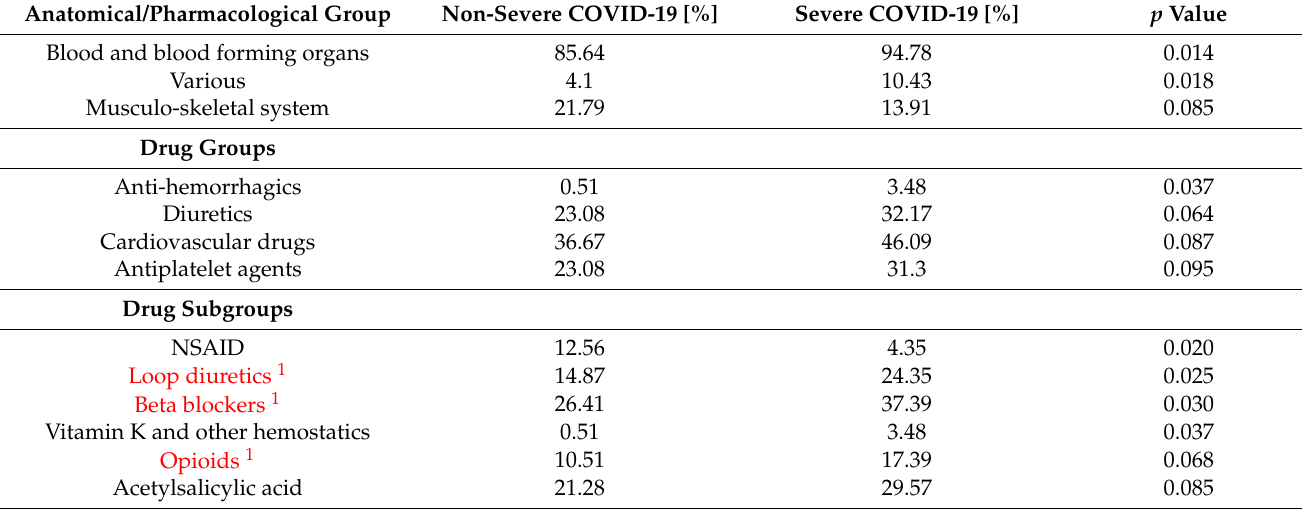
Table 2. Significant nodes of the DDSI network